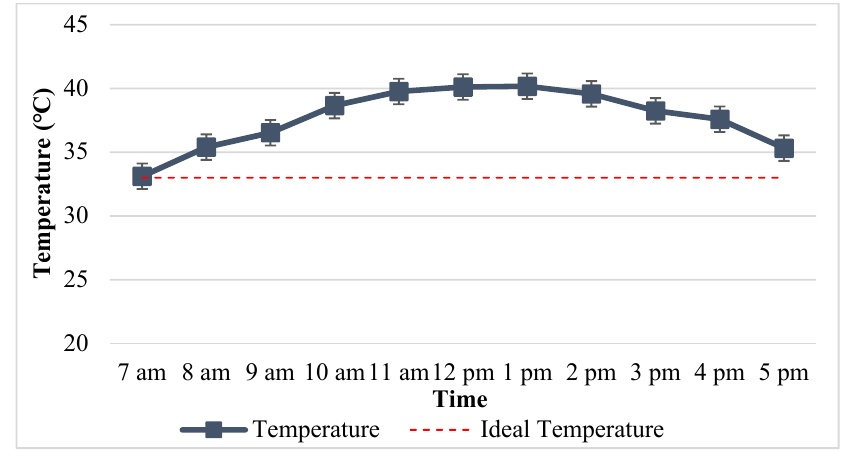
Figure 3. Greenhouse temperature without the misting system.